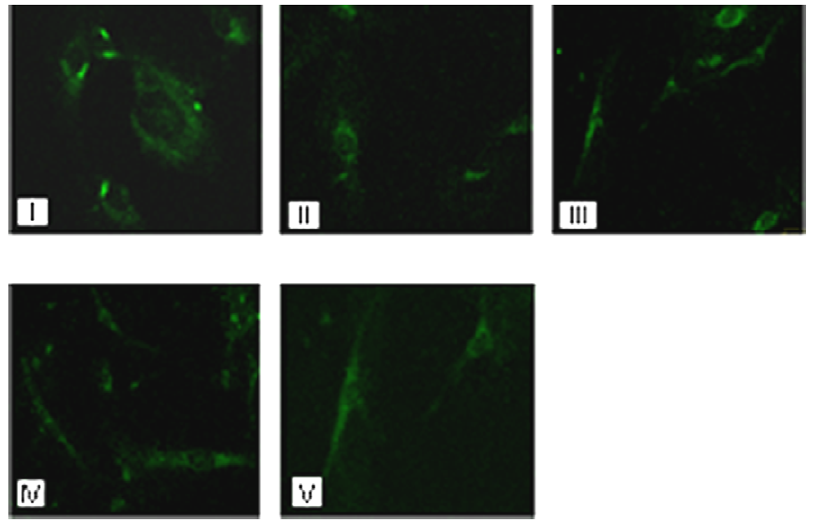
Figure 5. anb 3 integrin clustering assay. After culturing for 48 h with 20% V/V U266 c.m., HUVEC cells were fixed and stained with anti- a v b 3 antibody. Integrin clusters are evidenced as high density spots in the HUVEC treated with U266 c.m. (I), but not when HUVEC were incubated with c.m. derived from U266 treated with Gal-3C (II), Bor (III), or Gal-3C + Bor (IV). Clusters were also absent in HUVEC treated with EGM-2 medium alone (V). The figure shows representative photomicrographs obtained by confocal microscopy (60X magnification) from three independent